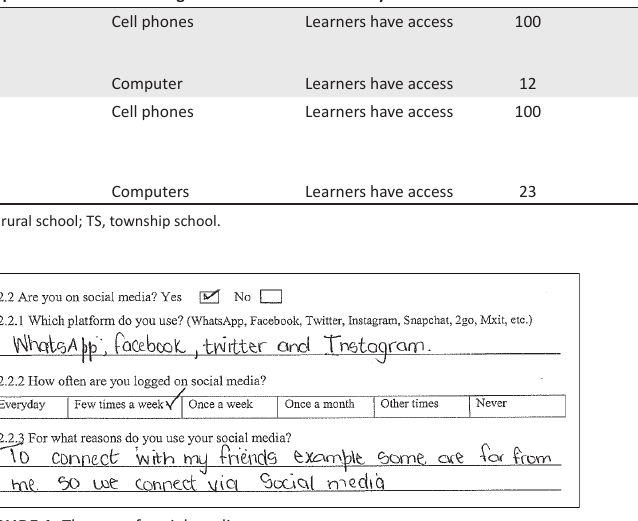
FIGURE 1: The use of social media.